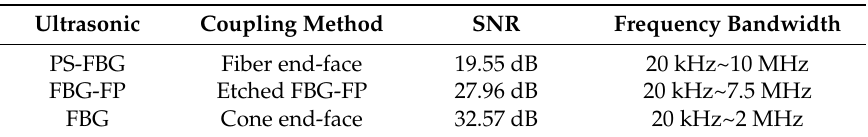
Table 4. FBG-based ultrasound